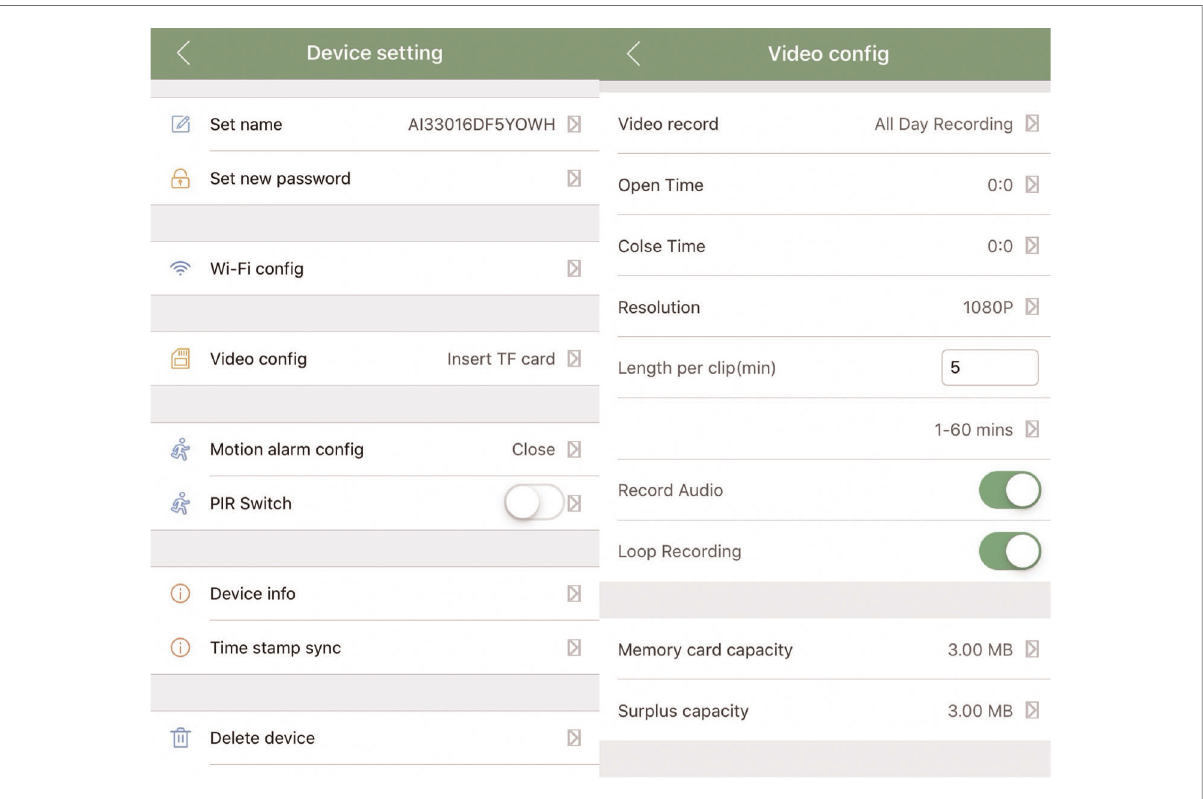
FIGURE 5 App software of the camera in